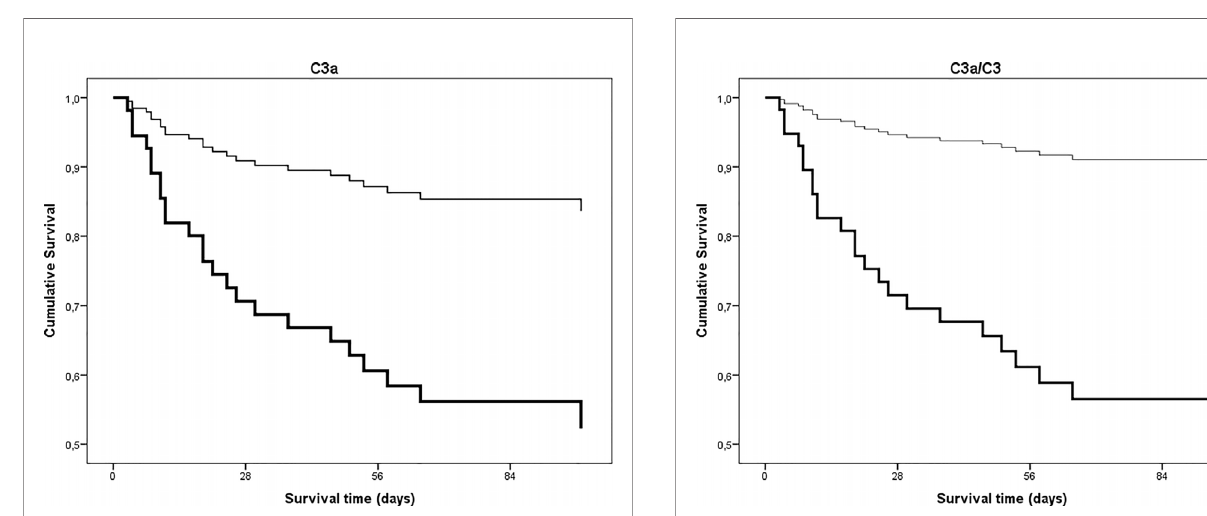
*C3a level and C3a/C3 ratio was analyzed as categorical variable, differentiating patients with high or low level of complement activation (cut points were 324 ng/mL for C3a; and 200 for C3a/C3). HR, Hazard ratio; CI, con fi dence interval.